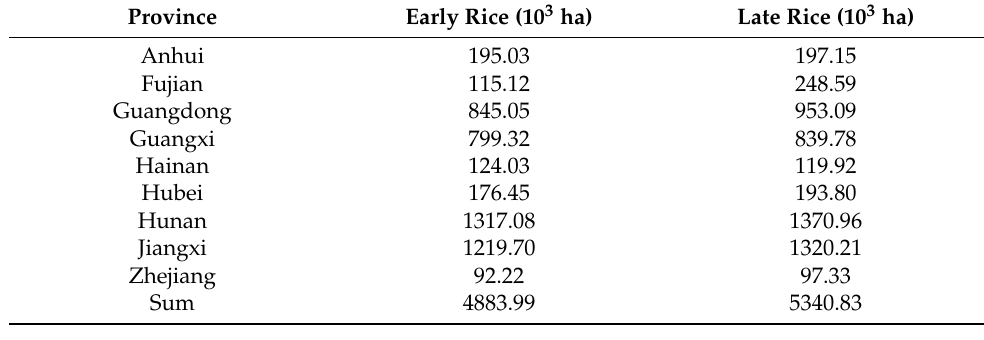
Table 1. Statistical area of early rice and late rice averaged from 2016 to 2019.